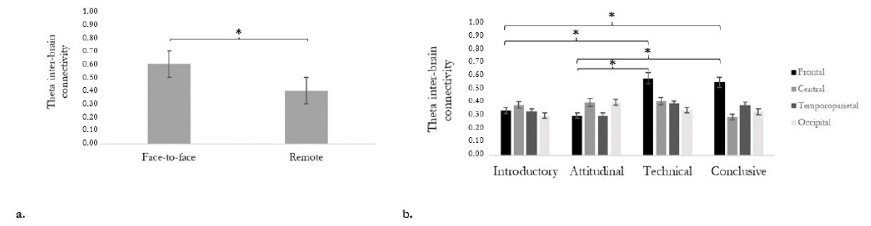
Figure 5. Theta inter-brain connectivity results. ( a ) Bar graph shows differences considering Con- dition. Bars represent ± 1 SE. Stars mark statistically significant pairwise comparisons. ( b ) Bar graph shows differences considering Interview*ROI. Bars represent ± 1 SE. Stars mark statistically significant pairwise comparisons.